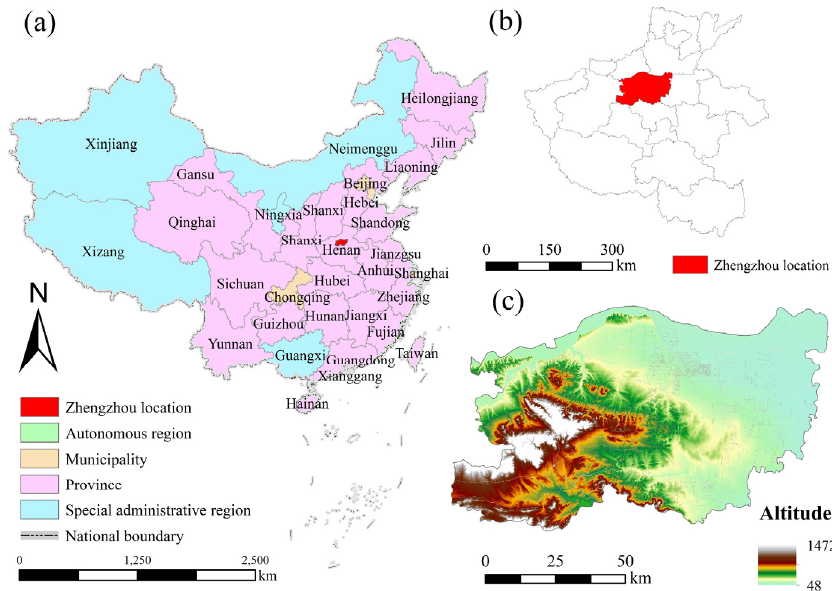
Figure 1. Geographic location ( a ), administrative district ( b ), and topography ( c ) of Zhengzhou re- gion.